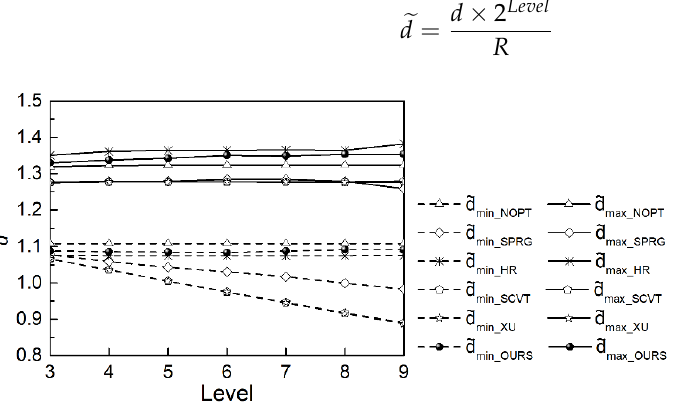
The grid distance was normalized according to Equation (17) to compare the differ ‐